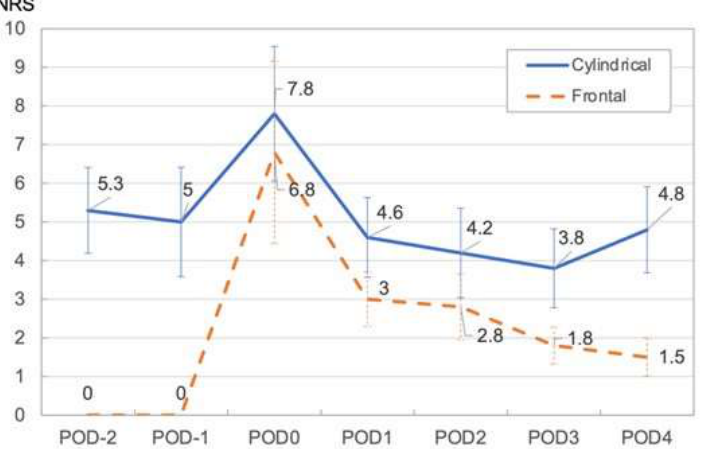
Figure 2. Mean NRS in Cylindrical and Frontal illumination method. Abbreviations: NRS: numerical rating scale, PIT: photoimmunotherapy, POD: postoperative day (days since treatment) . Table 2. NRS changes immediately after PIT.